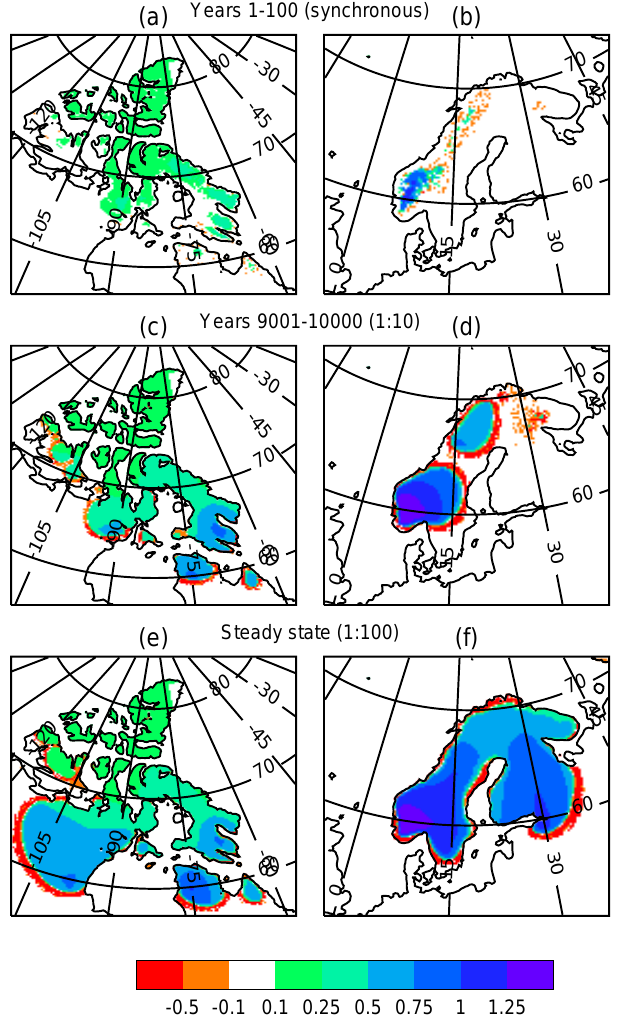
Fig. 7. Glimmer surface mass balance (ma − 1 liquid water equiva- lent) for the time-means indicated in the incipient glacial climate.